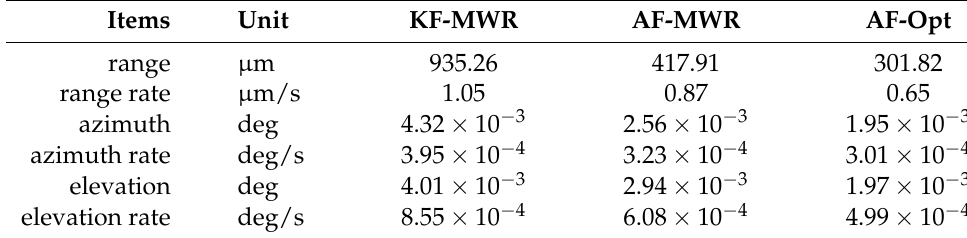
Table 4. Statistic of RMS for estimation